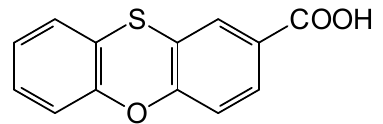
Figure 1. The structure of 3-carboxyphenoxathiin ( I ). OS